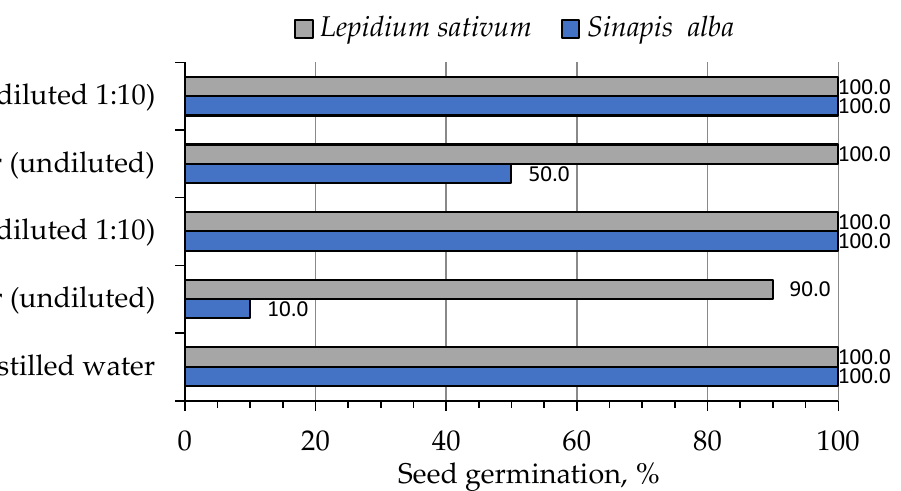
Table 10. Results of one-way ANOVA test for phytotoxicity tests. Tasted Plant Figure 7. Seed germination of S. alba and L. sativum L. for undiluted and diluted (1:10) wastewater samples.